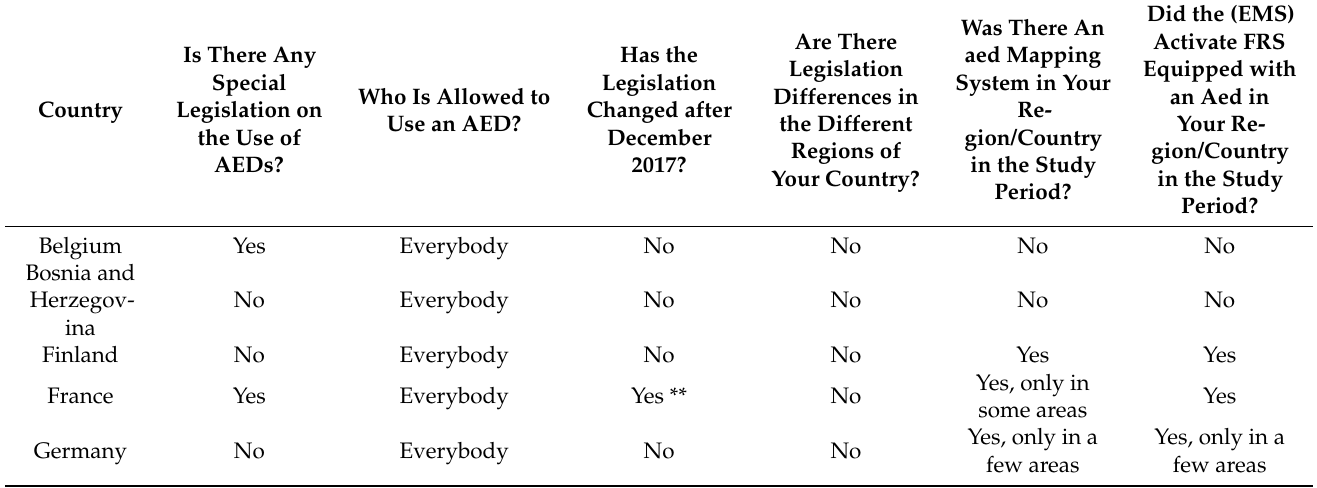
Table 1. AED legislation in different European countries updated in 2020 and the eventual differences compared with the EuReCa TWO period (late